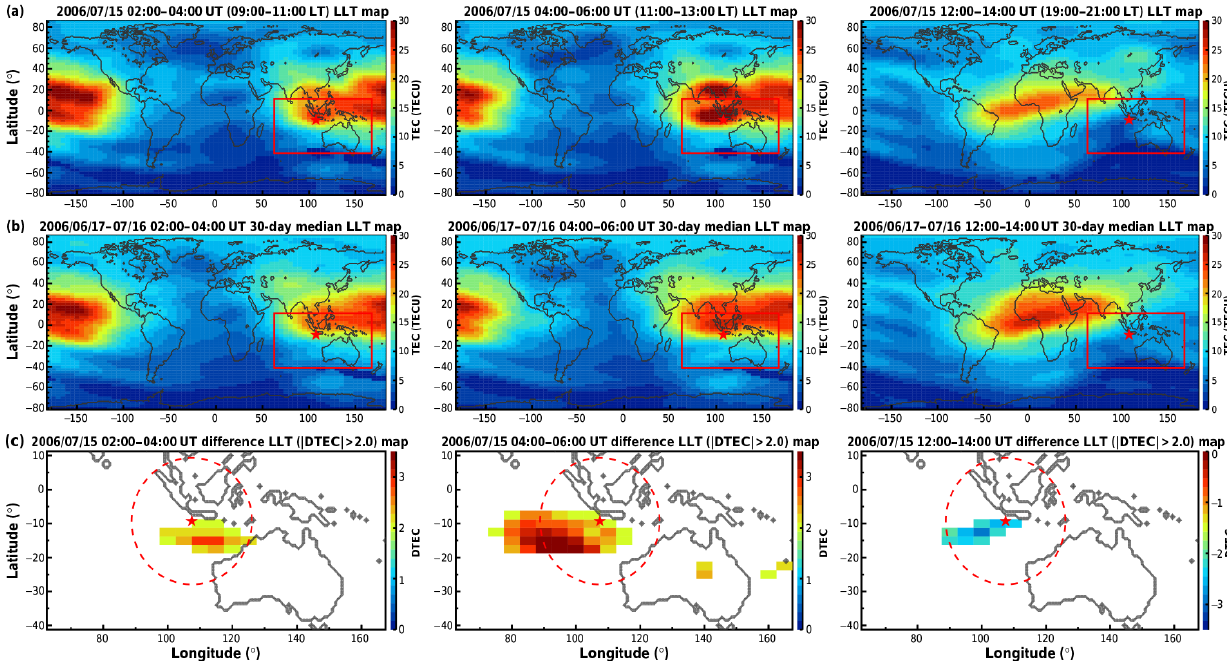
Figure 3. The GIM latitude–longitude–time (LLT) maps observed during the period of 02:00–04:00, 04:00–06:00 and 12:00–14:00UT on day 2 before the 17 July 2006 M 7.7 south of Java earthquake. The GIM LLT maps during the fixed period of 02:00–04:00UT (left column), 04:00–06:00UT (middle column) and 12:00–14:00UT (right column). Panels of row (a) are the observed values on day 2 before the earthquake (15 July 2006), while row (b) shows the median values of the period of days 1–30 before (17 June to 16 July 2006) the earthquake. The red squares in rows (a, b) indicate the regions of interest around the earthquake, in range of 41.25 ◦ S–11.25 ◦ N latitude and 62.5–167.5 ◦ E longitude. Panels of row (c) denote the extreme differences ( | DTEC | > 2 . 0 ) of the 30-day period that appeared on 15 July 2006. The color denotes the difference value of the TEC observed on 15 July 2006 from the relevant median value. The red dashed circles with the radius ρ = 2046 . 4km represent the earthquake preparation area of the